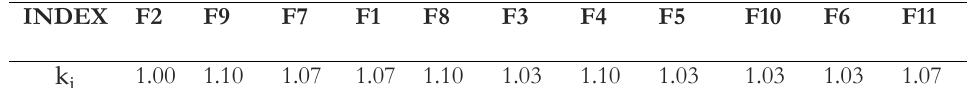
for each index. 𝐣